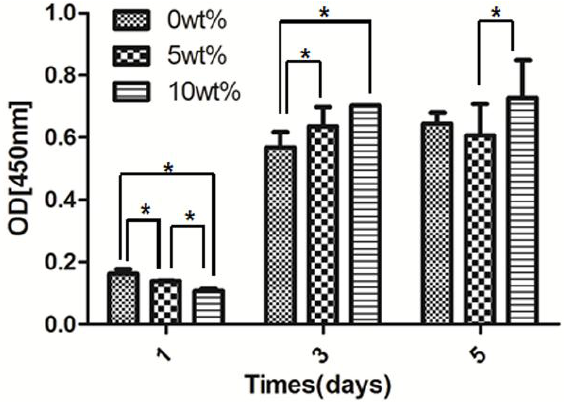
Figure 6. The proliferation of rBMSCs grown on various surfaces by CCK-8 assay after one, three, and five days culture. (* presented P < 0.05)